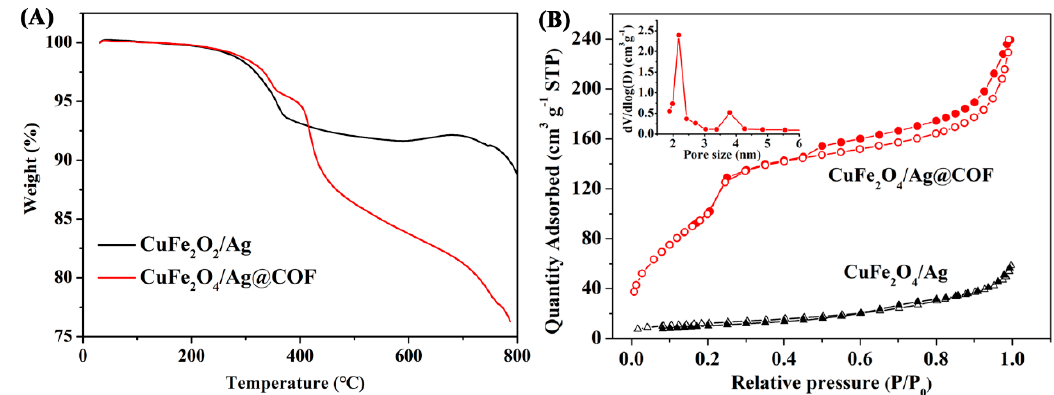
Figure 4. ( A ) Thermogravimetric analysis (TGA) curves of CuFe 2 O 4 / Ag and CuFe 2 O 4 / Ag@COF ( B ) N 2 Figure 4. (A) Thermogravimetric analysis (TGA) curves of CuFe 2 O 4 /Ag and CuFe 2 O 4 /Ag@COF (B) N 2 adsorption-desorption isotherms of CuFe 2 O 4 / Ag and CuFe 2 O 4 / Ag@COF (the inset shows pore size adsorption-desorption isotherms of CuFe 2 O 4 /Ag and CuFe 2 O 4 /Ag@COF (the inset shows pore size distribution of CuFe 2 O 4 / distribution of CuFe 2 O 4 /Ag@COF).